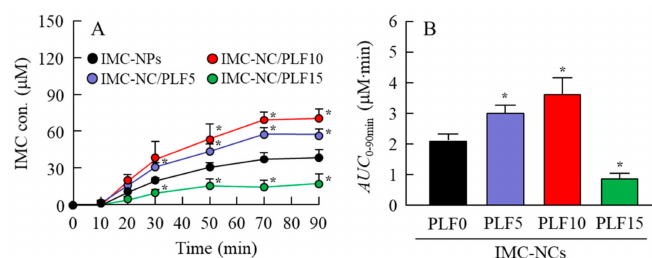
Figure 5. IMC levels in ( A ) lacrimal fluid (LF) and ( B ) blood of rabbits instilled with each ophthalmic IMC-NC formulation. Compositions of each ophthalmic IMC-NC formulation shown in Table 1; n = 6–8; * p < 0.05 vs. IMC-NPs for each category. Retention time of IMC levels in rabbit LF was enhanced with PLF-127 in IMC-NC-incorporating ISG. Addition of PLF-127 delayed IMC elimination in blood after instillation.